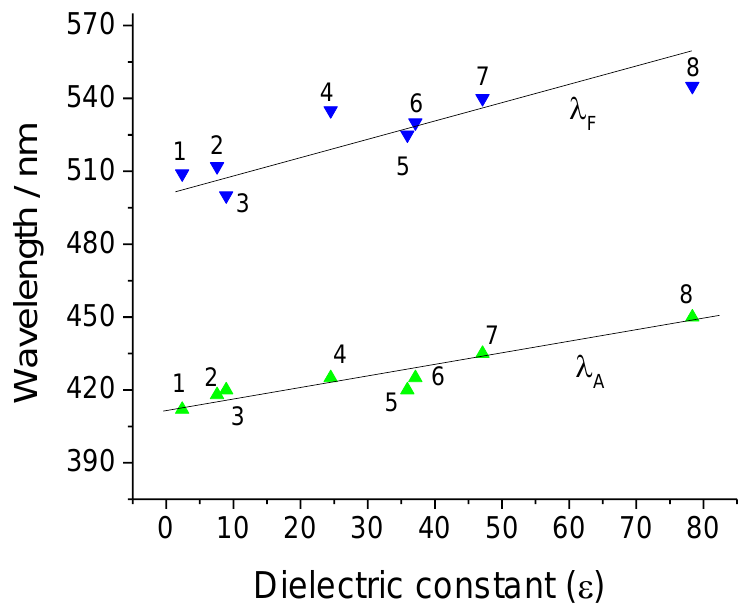
Figure 1. Dependence of absorption λ A and fluorescence λ F maxima of NI2 on the dielectric constant: 1 — Dioxane; 2 — Tetrahydrofuran; 3 — Dichloromethane; 4 — Ethanol; 5 — Acetonitrile; 6 — N , N -dimethylformamide; 7-Dimethyl sulfoxide; 8-Water.